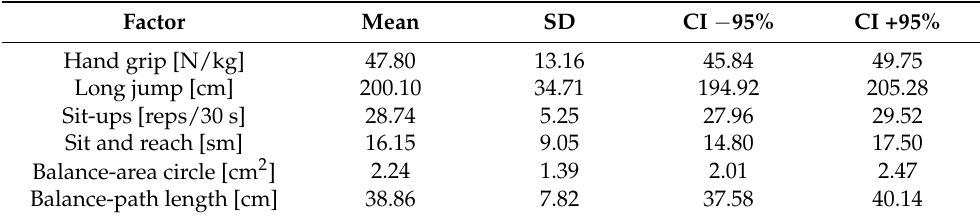
Table 1. Descriptive statistics of physical performance test